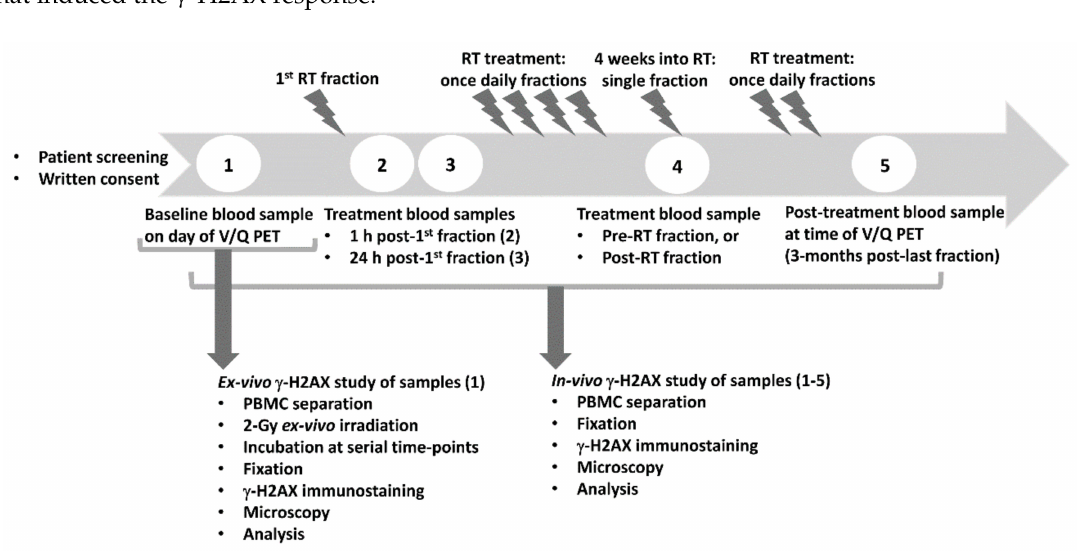
Figure 1. Experimental scheme of the study. Patients with non-small cell lung cancer (NSCLC) were recruited for the GalliPET VQ-RT clinical trial. The γ -H2AX biomarker study was a biological part of the clinical trial. Venous blood was collected at the indicated time points before, during and after radiotherapy (RT) treatment and processed as described in Section 4. Peripheral blood mononuclear cells (PBMC) collected at all time points were not exposed to ex vivo irradiation (in vivo γ -H2AX study), except an aliquot of a baseline PBMC sample that was subsequently ex vivo irradiated (ex vivo γ -H2AX study). Ventilation / perfusion (V / Q) positron emission tomography (PET) prior to treatment and post-treatment enabled assessment of treatment toxicity and tumour